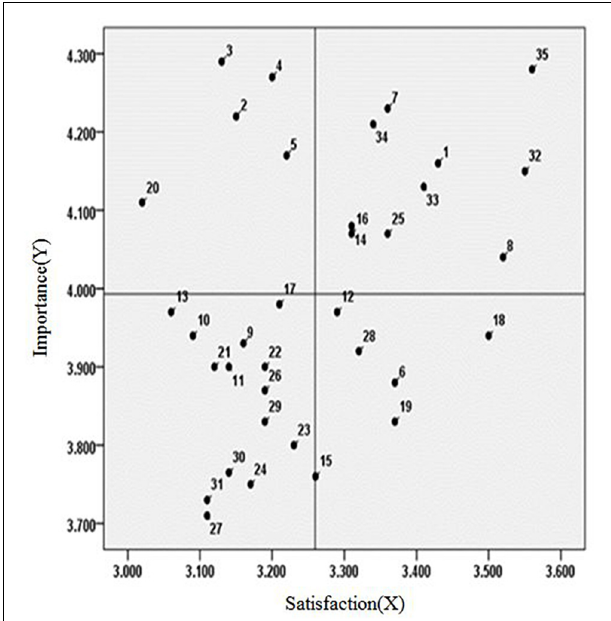
FIGURE 3 | Importance–performance analysis on UFM